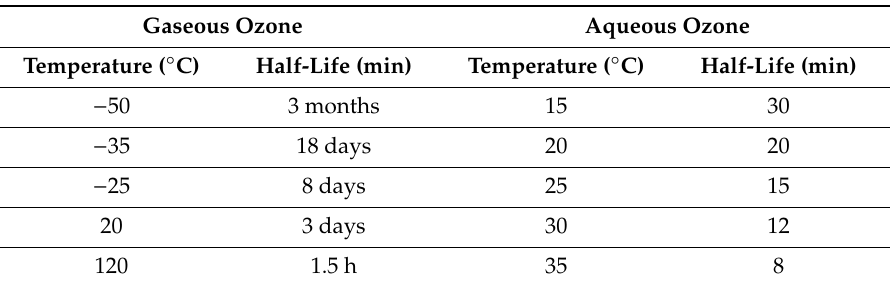
Table 2. Ozone half-life based on temperature